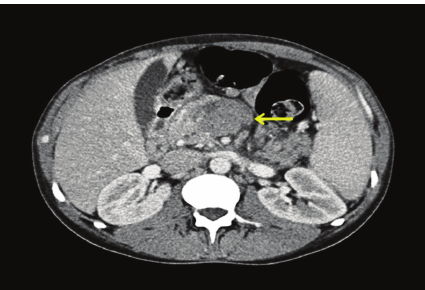
Figure 1: Contrast-enhanced computed tomography at the level of pancreas. Arrow demarcates multiple peripancreatic soft tissue masses to left of the uncinate process.